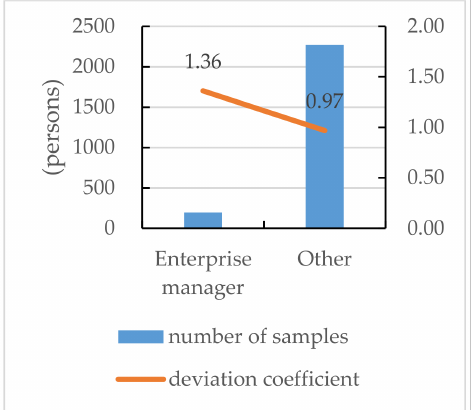
Figure 9. Deviation coefficient of agricultural machinery utilization rate grouped by social